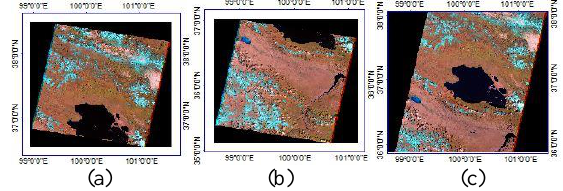
Figure 5. Qinghai Lake image after Mosaic ((a) and (b) before Mosaic; (c) after